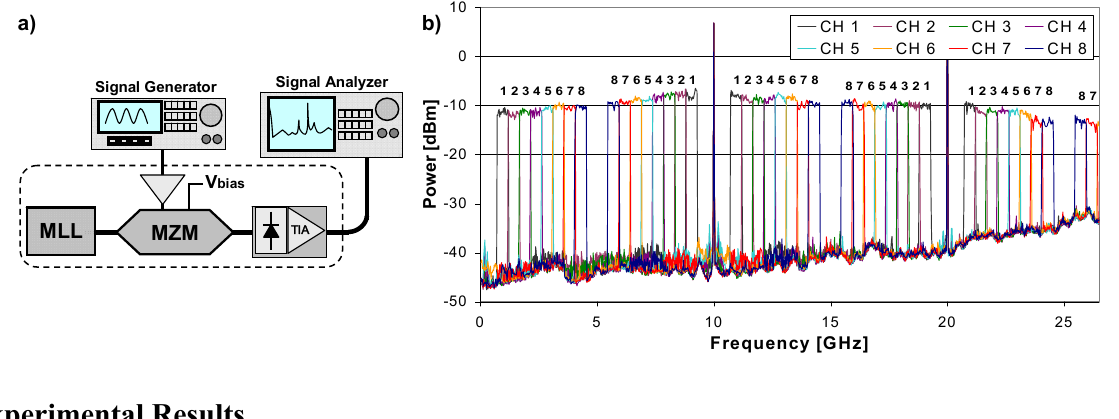
Figure 2. ( a ) Experimental setup. TIA: Trans-impedance amplifier; ( b ) Electrical spectrum of the transmitted signal. The channels are numbered in order of increasing